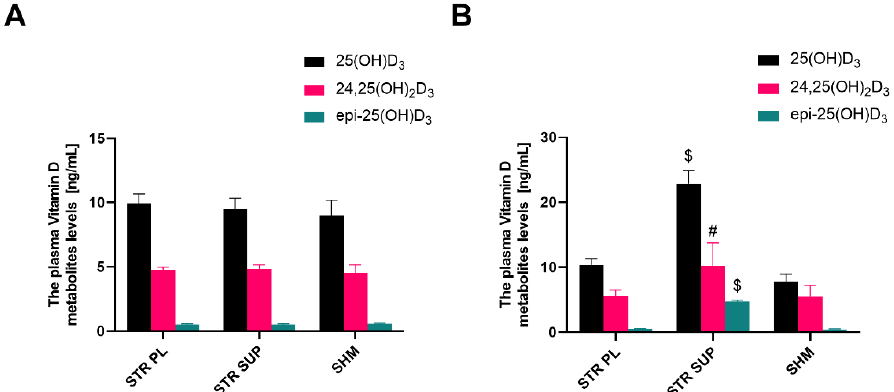
Figure 3. The plasma vitamin D metabolite levels in stressed rats at baseline ( A ) and the end of the experiment ( B ). Results are expressed as mean ± SEM. STR PL ( n = 9), STR SUP ( n = 9), SHM ( n = 6), # p < 0.01 vs. STR PL; vs. SHM, $ p < 0.0001 vs. STR PL; vs. SHM. STR PL: cold water immersion group supplemented with placebo; STR SUP: cold water immersion group supplemented with vitamin D 3 ; SHM: sham cold water immersion group.